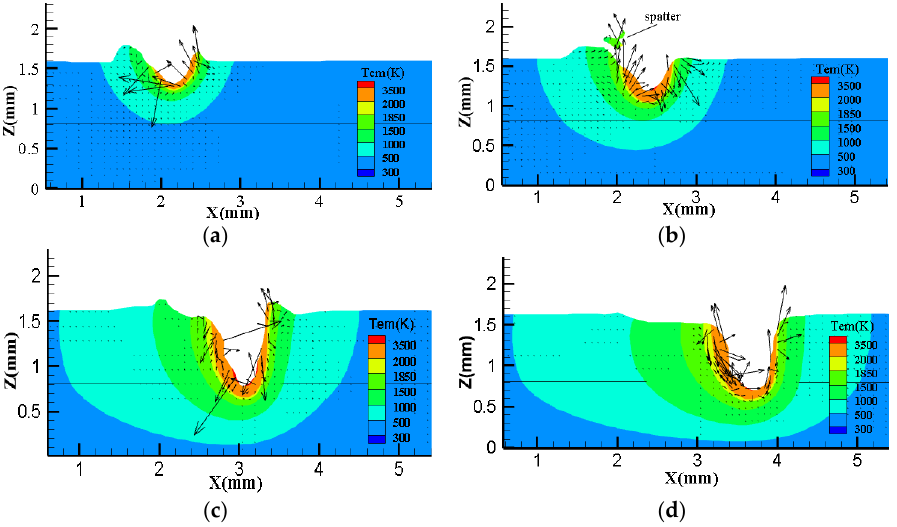
Figure 2. Longitudinal section views of the calculated temperature and velocity fields in laser welding (laser power 500 W, welding velocity 3.6 m/min): ( a ) t = 3.05 ms; ( b ) t = 7.20 ms; ( c ) t = 18.20 ms; ( d ) t = 28.35